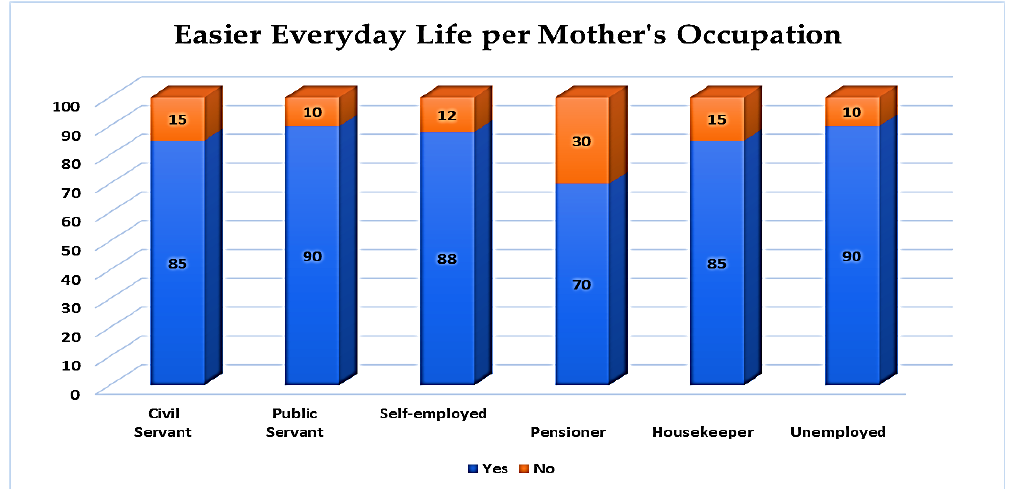
Figure 16. Easier day life due to the BS.